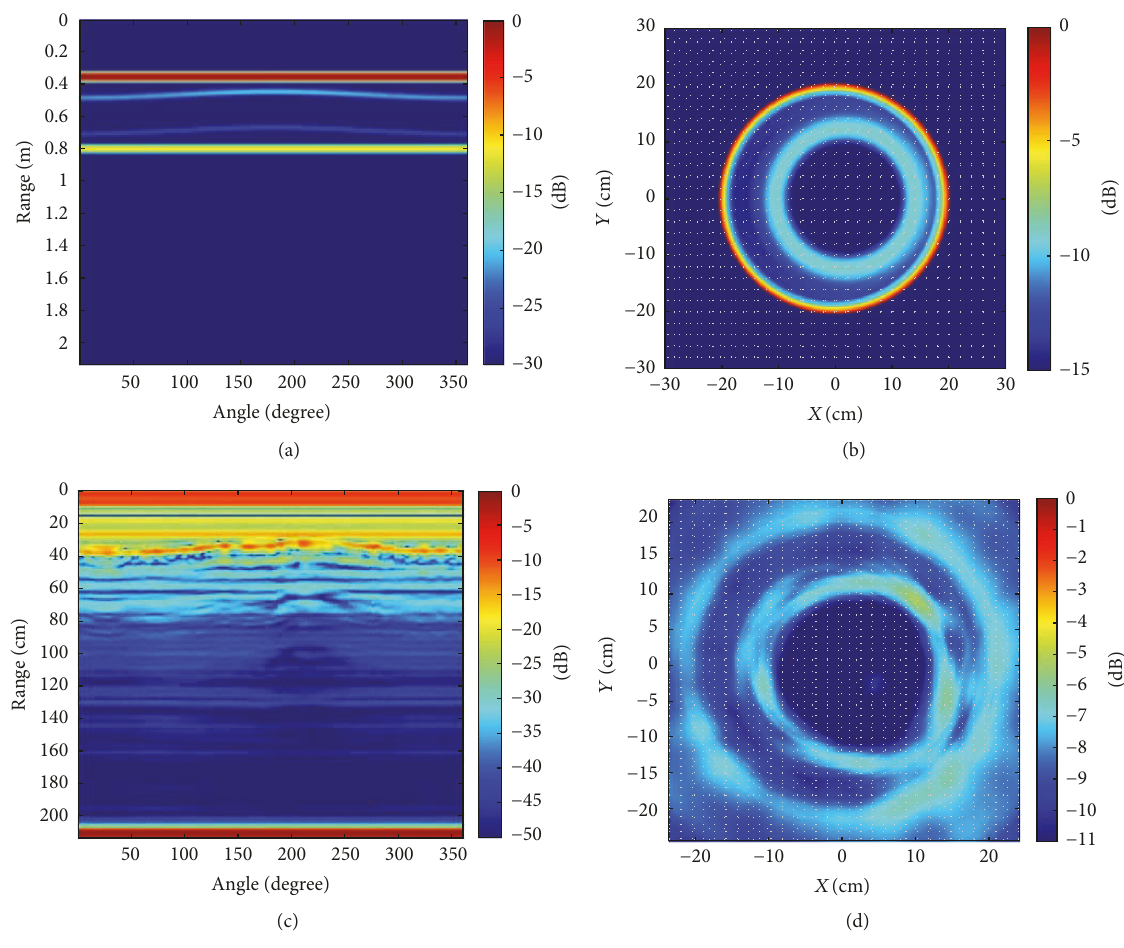
Figure 6: Simulation and measured results for the experiment: (a) simulated range-angle data, (b) simulated TIIR image, (c) measured range-angle data, and (d) measured TIIR